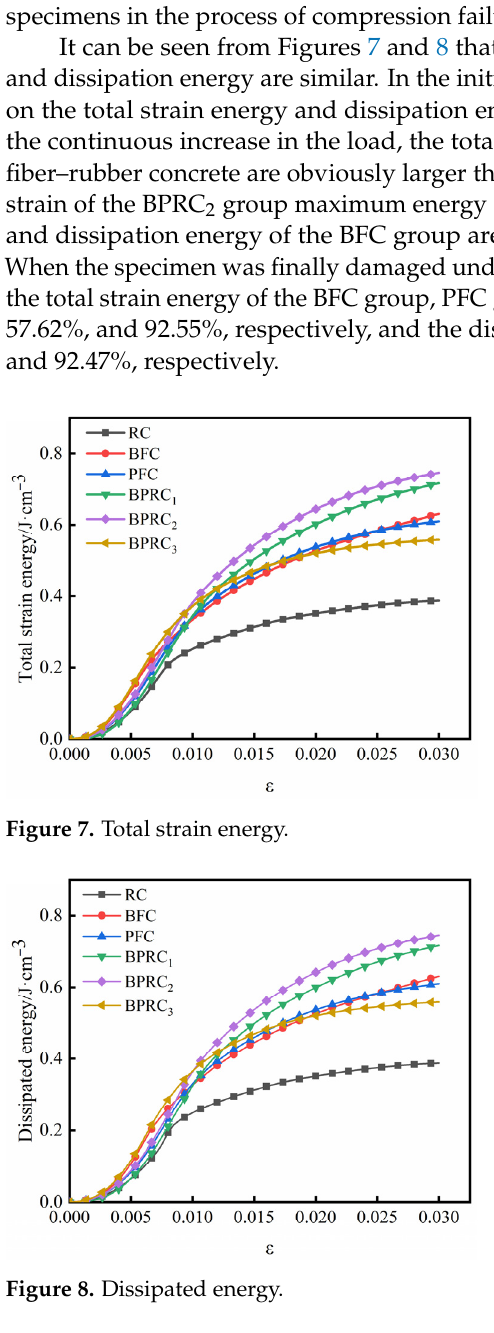
Figure 9. Elastic strain energy. 3.2.4. Law of Energy Conversion The ratio of the elastic strain energy to the total strain energy represents the conver- sion rate of the elastic strain energy of the specimen during the process of compressive